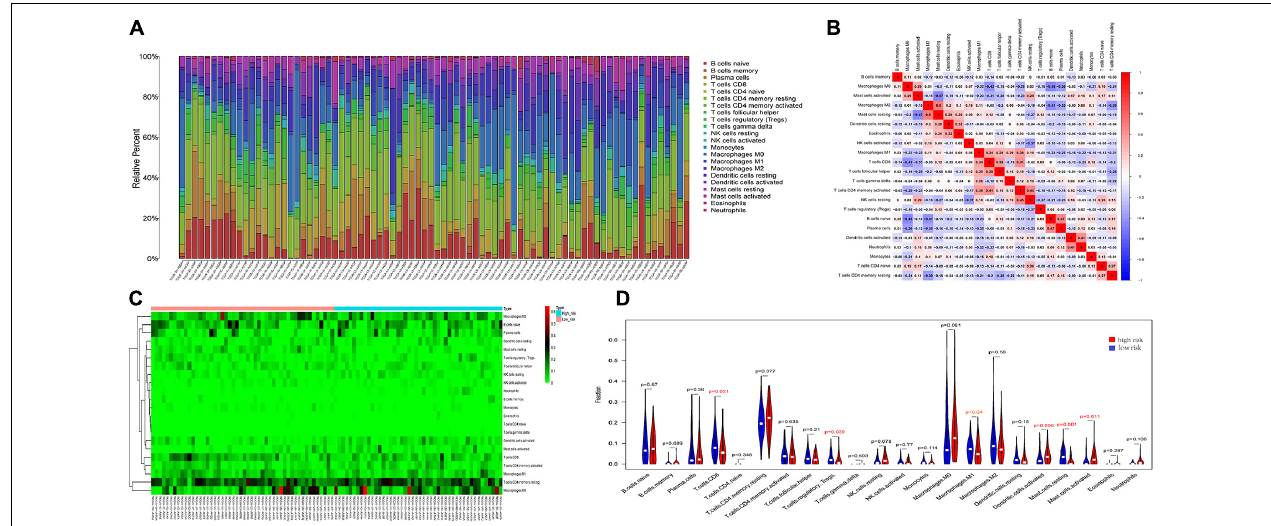
FIGURE 9 | Immune cell infiltration landscapes in high- and low-risk patients with ESCA. (A) Relative level of immune cell infiltration in high- and low-risk patients. (B) Correlation matrix and (C) heatmap of the 22 immune cell proportions. (D) Differences in immune cell infiltration between high- and low-risk